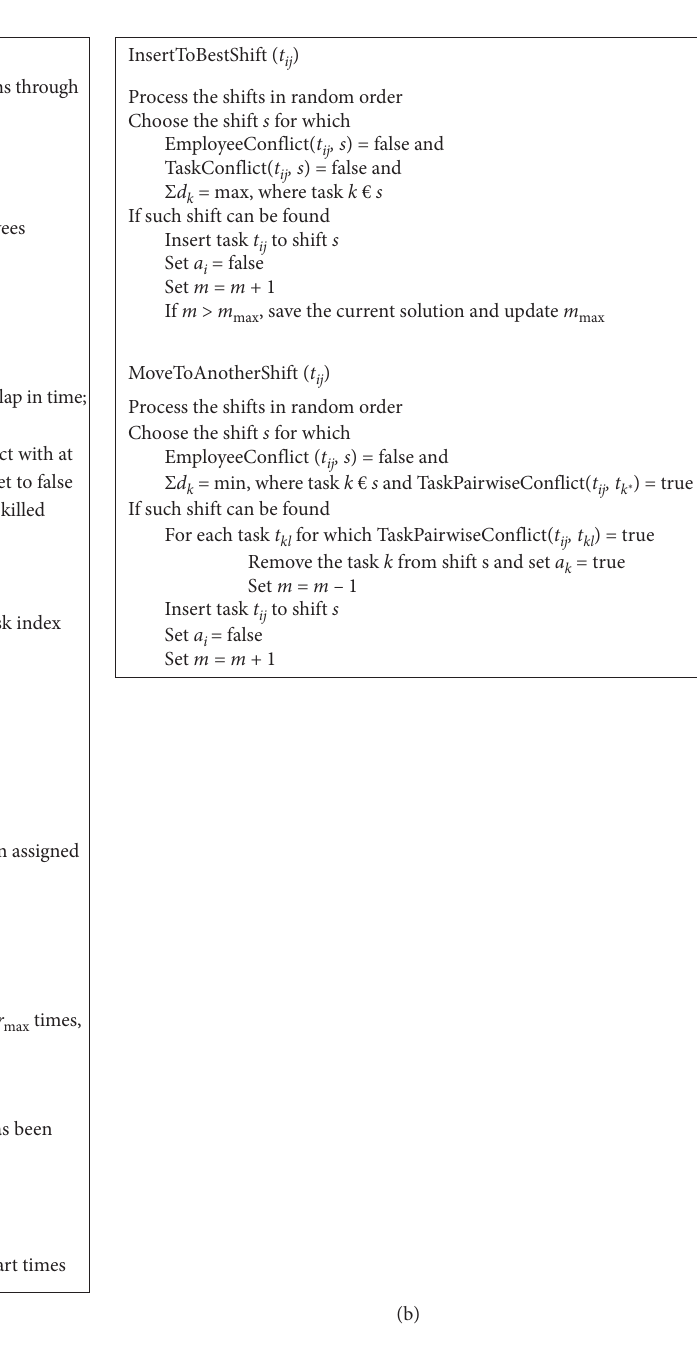
Figure 3: (a), (b) The pseudocode of the iterated construction